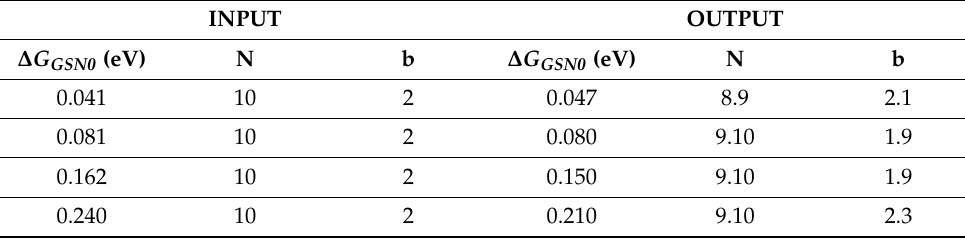
Table 3. Input versus output for selected REES and free energy landscape (FEL)